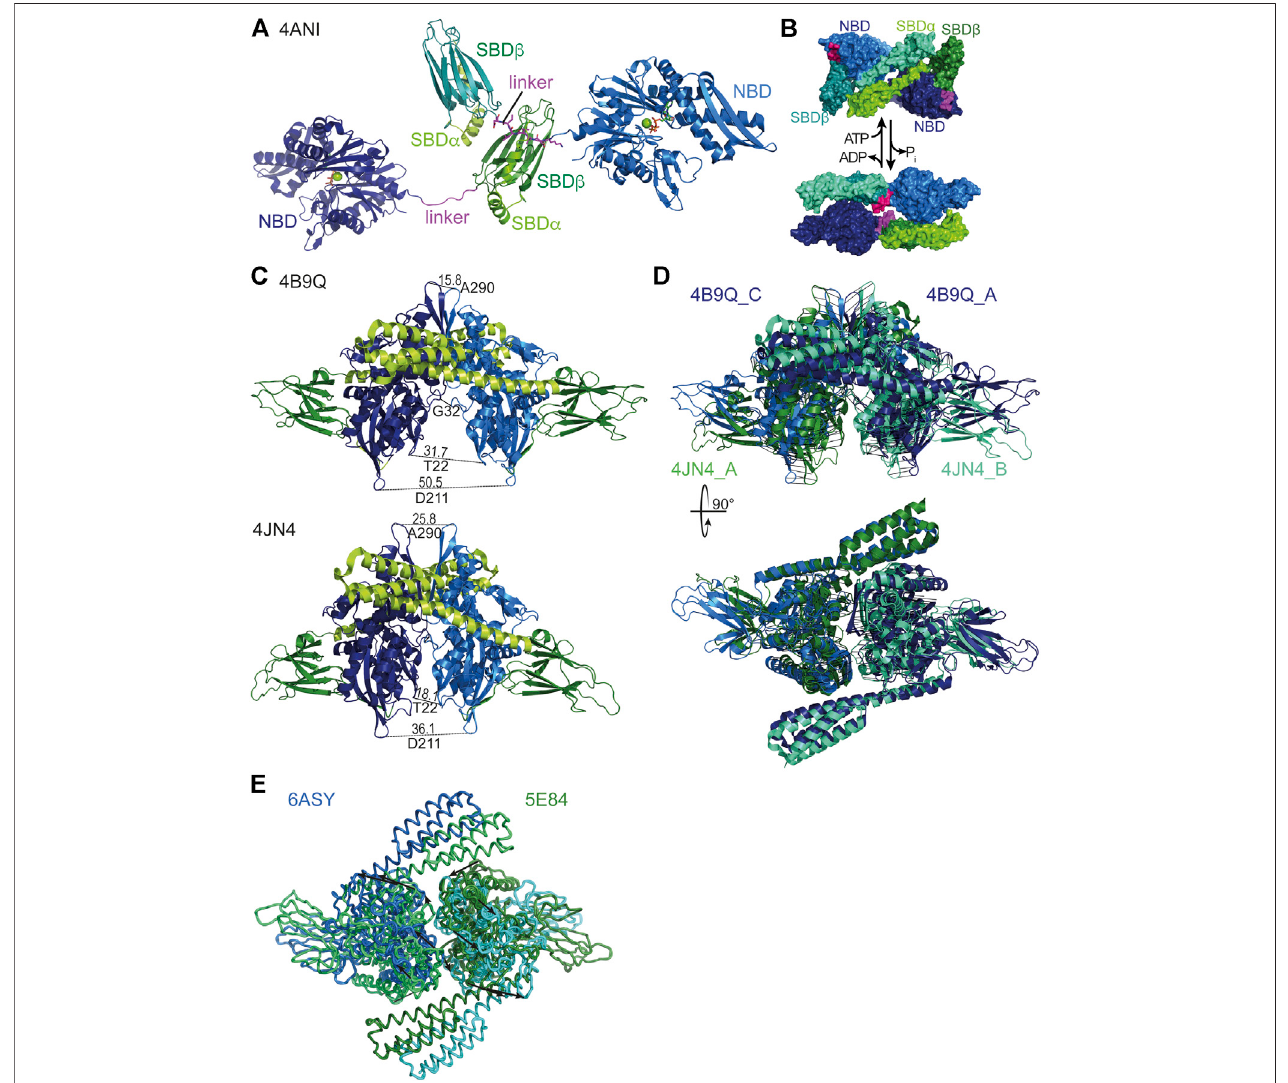
FIGURE 7 | Oligomeric states of Hsp70s. (A) , dimeric assembly of G. kaustophilus DnaK with SBD β of one DnaK molecule binding to the linker (magenta) of a secondDnaKmolecule[4ANI,(Changetal.,2008a)]. (B) ,Hsp70 · ATPSBD α -SBD α dimericassembly(4B9Qtop)andHsp70 · ADPhead-to-tailassembly(2KHO,bottom) asproposedbasedonnativemassspectrometryandcross-linking(Morgneretal.,2015). (C) ,DnaK · ATPdimersasfoundinthecrystalstructures[top,4B9Q(Kityketal., 2012); bottom, 4JN4 (Qi et al., 2013)]. To illustrate the differences the distances between identical residues in the two protomers are indicated. (D) , Overlay of the twocrystalstructuresofDnaK · ATPbypairwisealignmentofallresiduesintheNBDs(4B9QchainA(darkblue)andC(lightblue)to4JN4chainA(greencyan)andB(dark green); RMS (cid:2) 4.573 over 747 residues). Black lines connect corresponding residues. Lower panel, same overlay rotated by 90 ° as indicated. (E) , Overlay of the two crystalstructureofhumanBiP[5E84,(Yangetal.,2015a),and6ASY,(Yangetal.,2017)].Arrowsconnectcorrespondingresiduesandindicatetherelativerotationofthe protomers in the different dimer